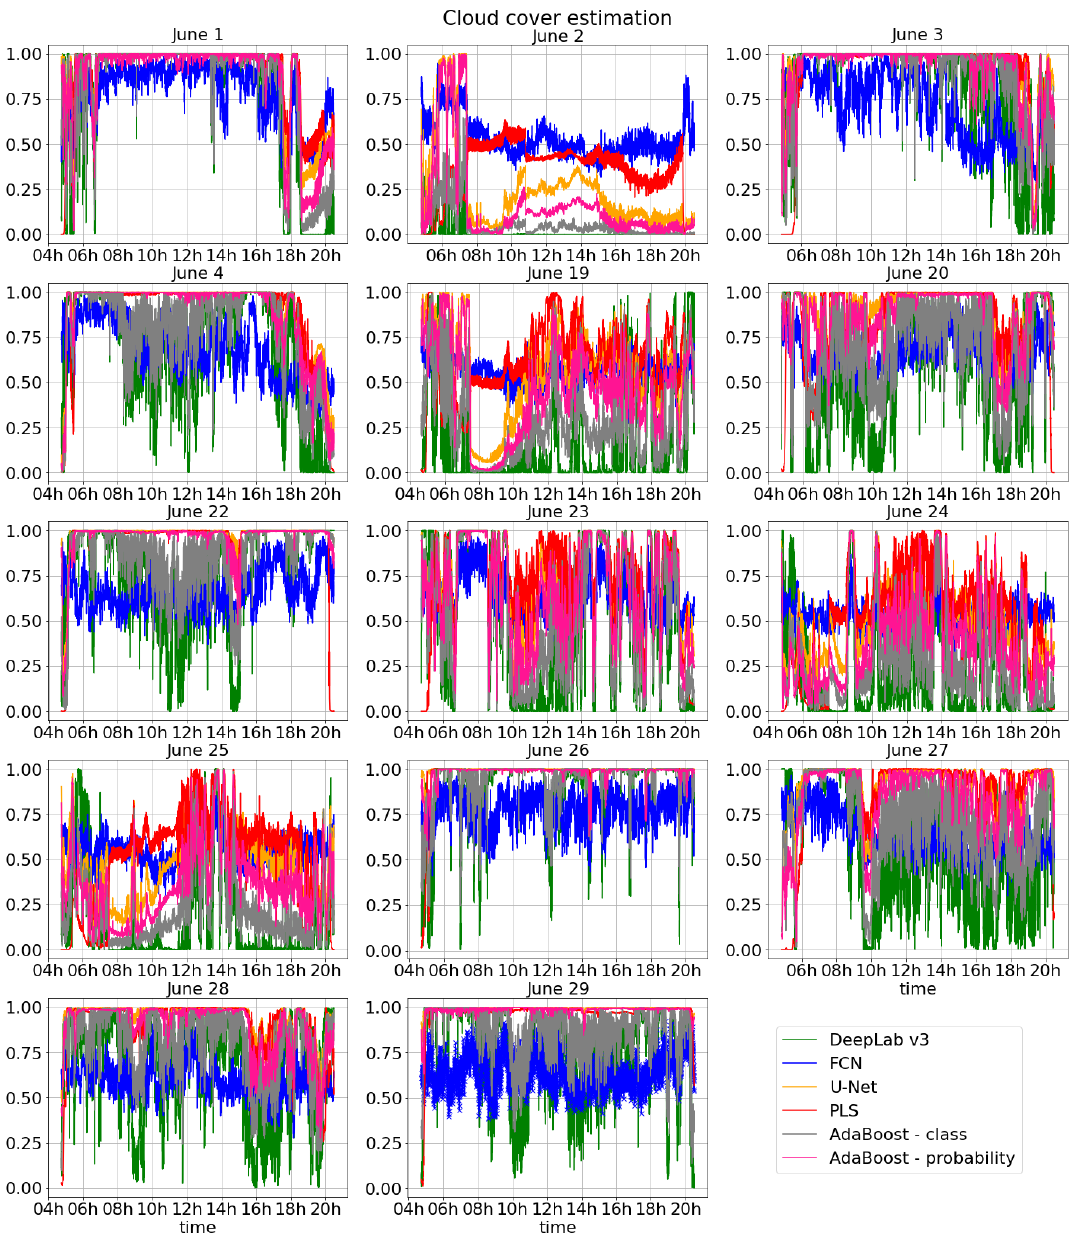
Figure A1. Cloud cover estimation results for the 14